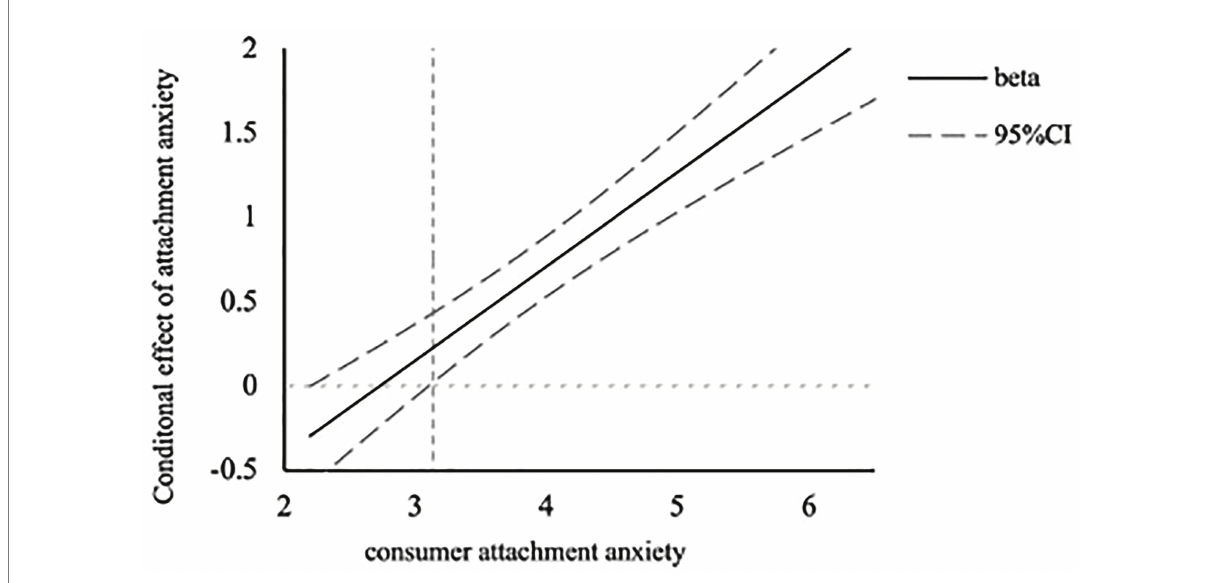
FIGURE 3 The Johnson- Neyman analysis of consumer attachment anxiety for Study